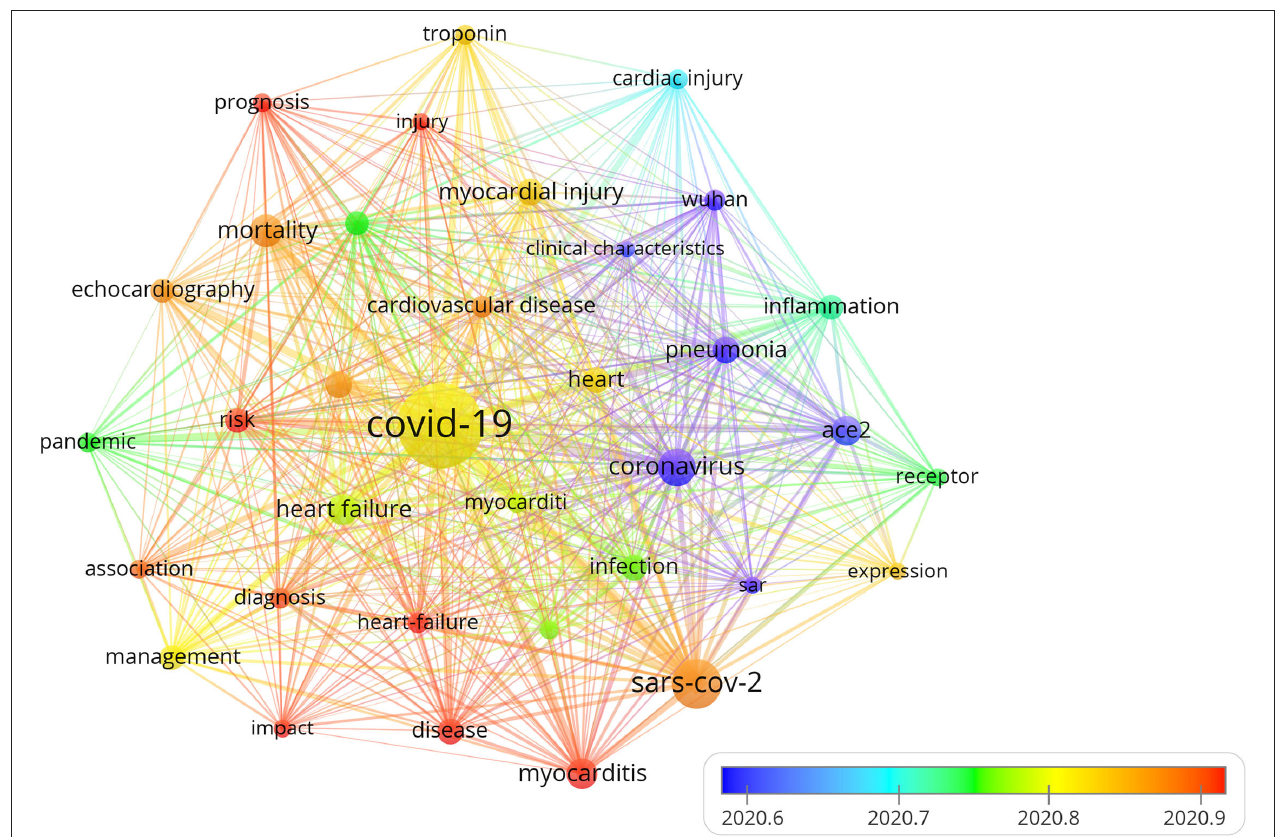
FIGURE 8 | The timeline visualization map of keywords clustering analysis on cardiac involvement in COVID-19. Different colors represented different years. The warmer the color was, the closer the year. This figure displayed a timeline chart of COVID-19-mediated cardiac involvement based on VOSviewer software. The figure visually reflected the phased hotspots and epidemic status of severe COVID-19 from the time dimension. The initial research mainly focused on pneumonia caused by coronavirus through the receptor of ACE2 in Wuhan. With the spread of the disease, it was found that severe pneumonia infection with an obvious inflammatory response mediated by SARS-CoV-2 can lead to cardiac injury. With the global pandemic of COVID-19, the keywords referring to myocadiac injury, including HF, myocarditis, and troponin had become increasingly prominent. With the deepening understanding of the disease, further identification of HF and myocarditis through echocardiography was of great significance for the prognosis in severe COVID-19